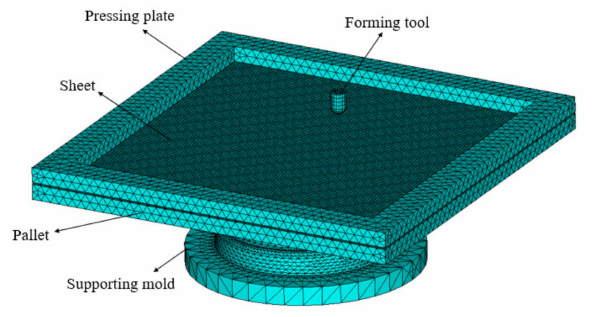
Figure 5. Finite element mesh model.